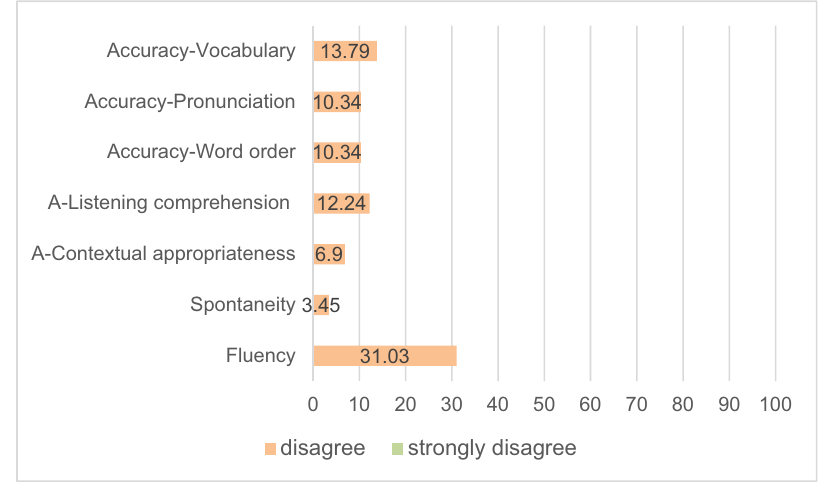
Figure 3: Disagreement rates in self - perception of L1 Japanese abilities ( % )